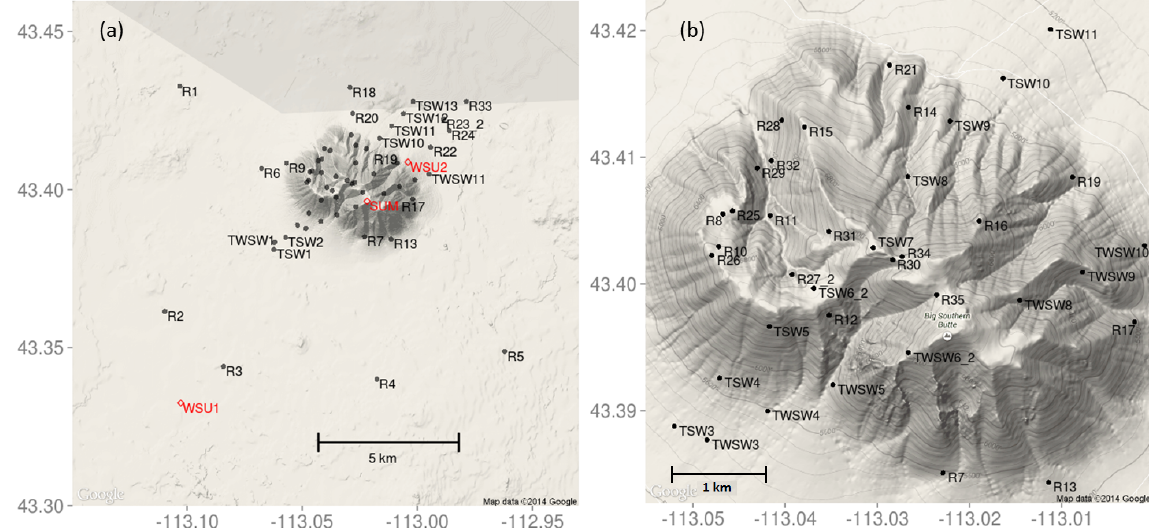
Figure 1. Sensor layout at Big Southern Butte (a) zoomed out to show the entire study area and (b) zoomed in to show sensor detail on the butte. Black circles indicate surface sensors. Red diamonds indicate sonic anemometers and vertical profiling sensors.